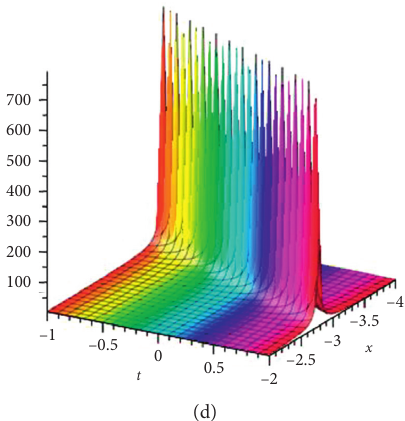
Figure 8: 3D graphics of Families 22, 23, and 24 under the values α � 0, k � y � 1, ω � 0 . 5, σ � 0 . 5, μ � 0 . 25, and A � 2 . 5 for (a) Φ , (c) Φ with β � 0 . 5, and (d) Φ β � 0, (b) Φ 35 36